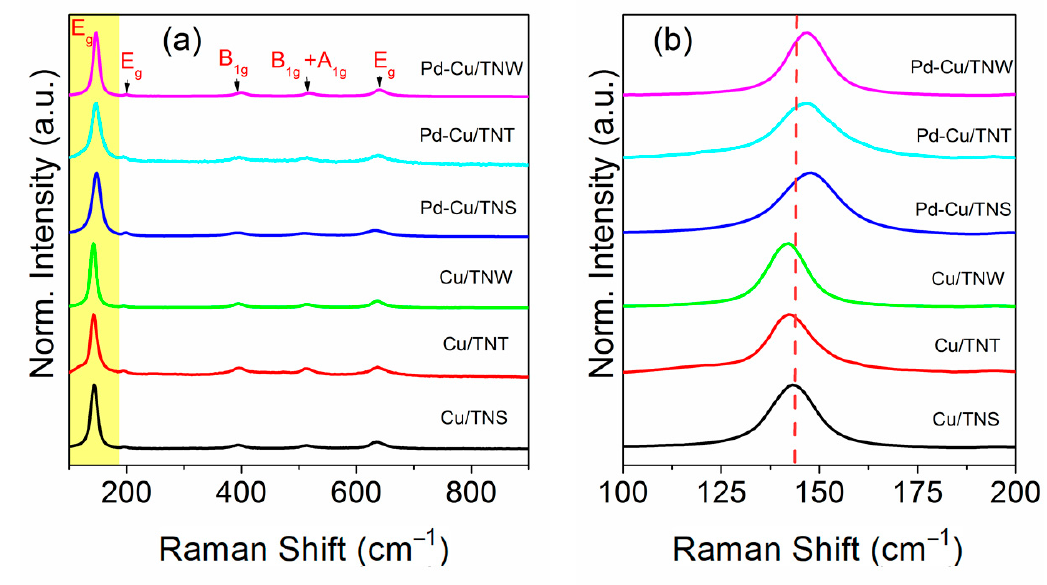
Figure 7. ( a ) Raman spectra of Cu-TNS, Cu-TNT, Cu-TNW, Pd-Cu-TNS, Pd-Cu/TNT, Pd-Cu/TNW catalysts ( b ) Raman spectra of Eg mode of TiO 2 .